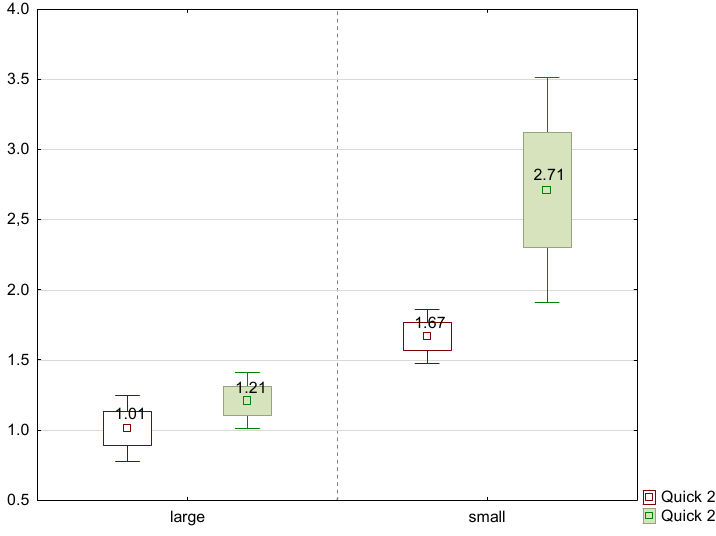
Figure 5. Speed indicator by company size in 2018 and 2019.